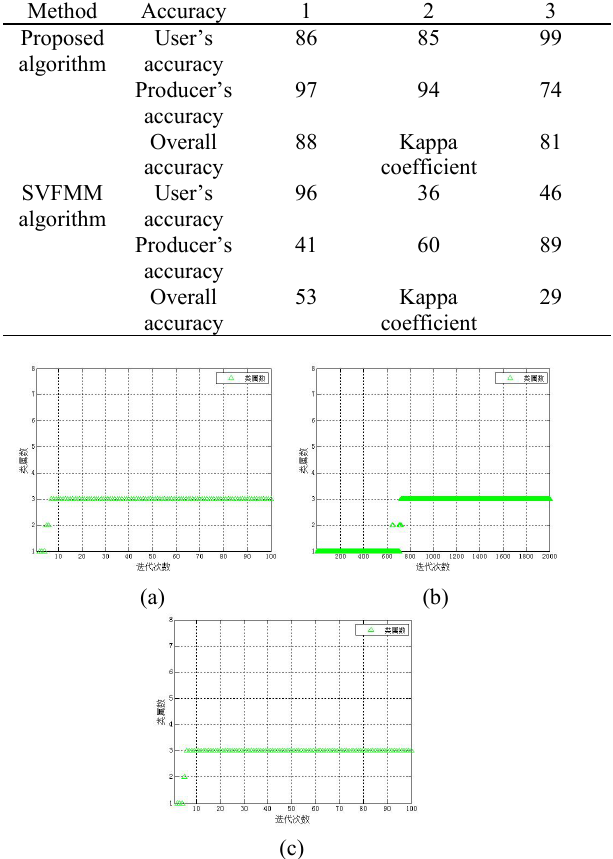
Figure 5 convergence image for the number of